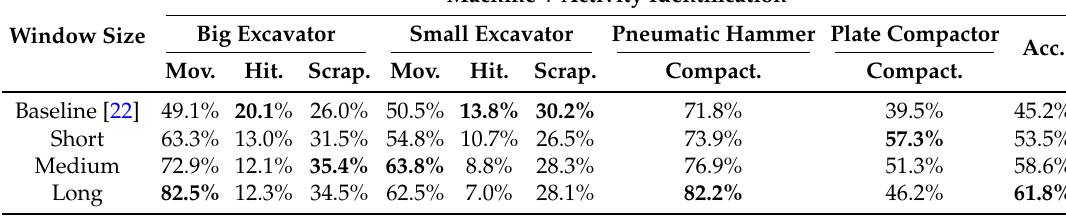
Table 2. MLP classification accuracy for the machine + activity identification mode for every class with various window sizes with the best result for each class in bold font. ”Acc.” is the overall classification accuracy, with the best result in bold font. ”Mov.” stands for moving; ”Hit.” stands for hitting; ”Scrap.” stands for scrapping; and ”Compact.” stands for